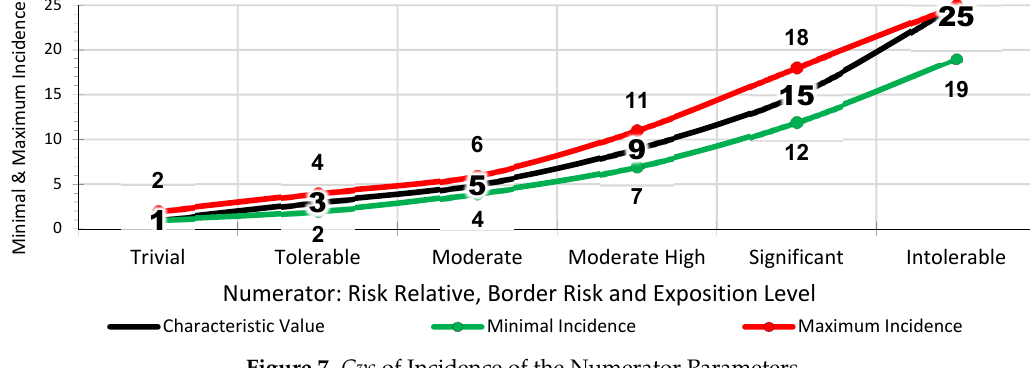
Figure 7. Cvs of Incidence of the Numerator Parameters. Figure 7. Cvs de incidencia de los parámetros del numerador. Figure 7. Cvs de incidencia de los parámetros del numerador.